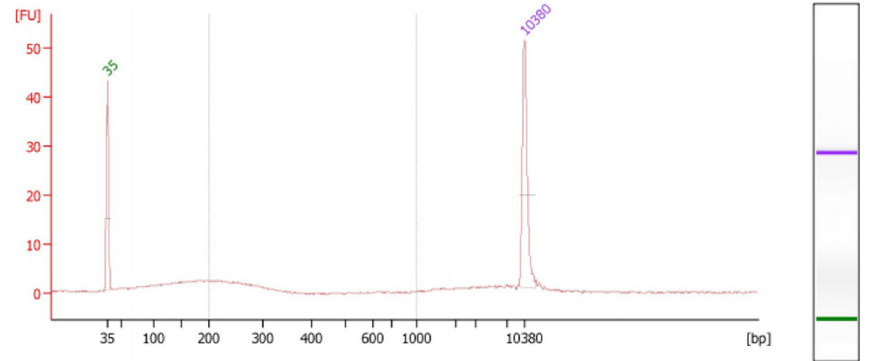
Figure 2. Sample extraction High Sensitivity DNA bioanalyzer trace for EV-associated DNA from patient